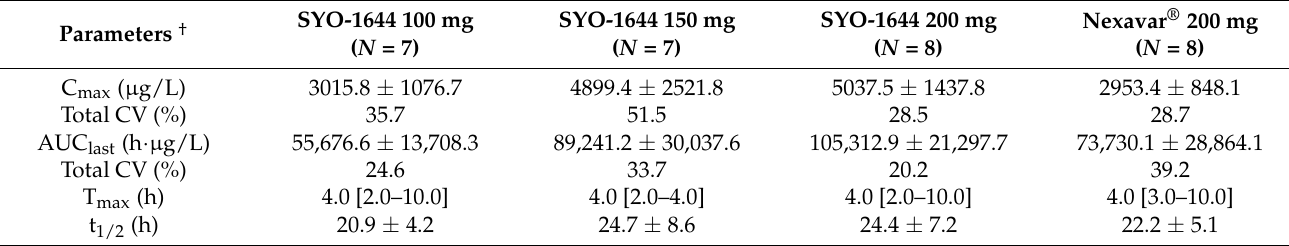
Table 1. Summary of pharmacokinetic parameters of